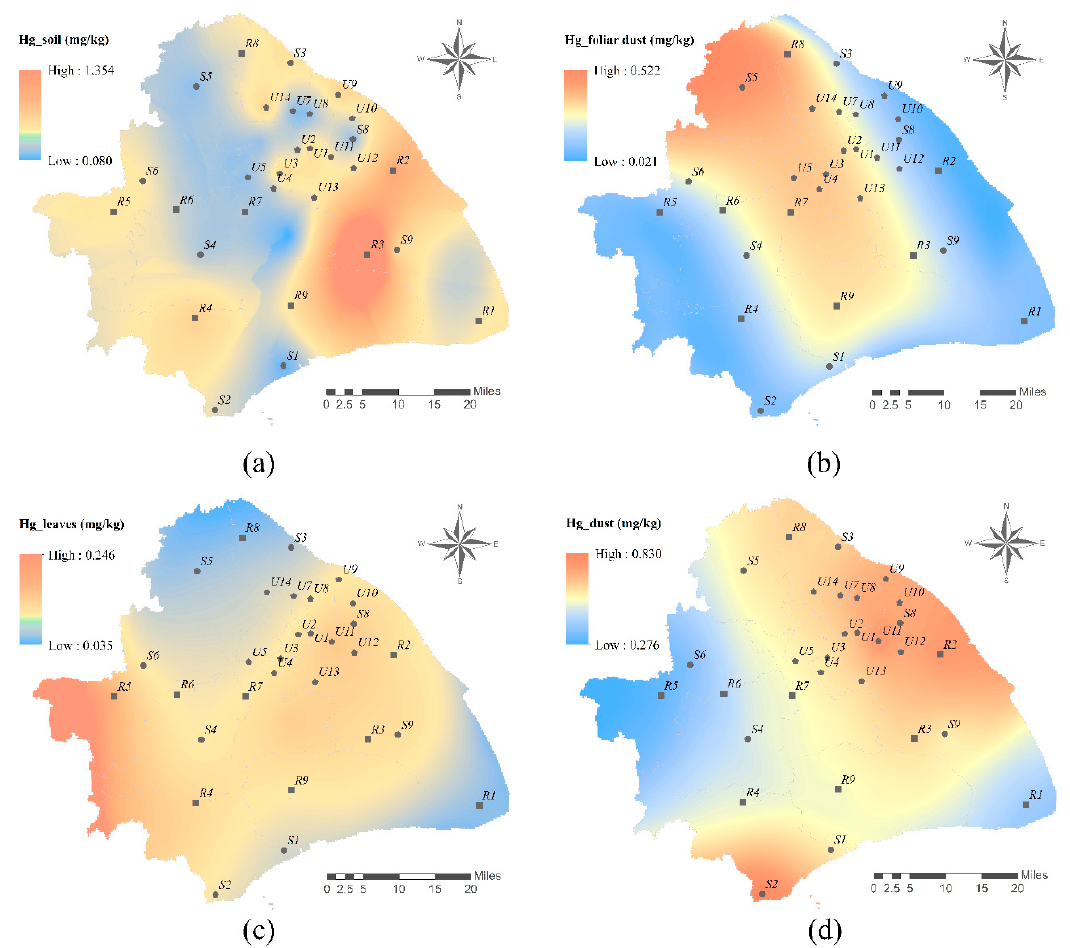
Figure 2. Interpolation map of mercury concentrations in four media in Shanghai, ( a ) soil, ( b ) foliar dust, ( c ) camphor tree leaves, and ( d ) dust. R: rural area (R1–R9); S: suburban industrial area (S1–S9); U: urban area (U1–U14).